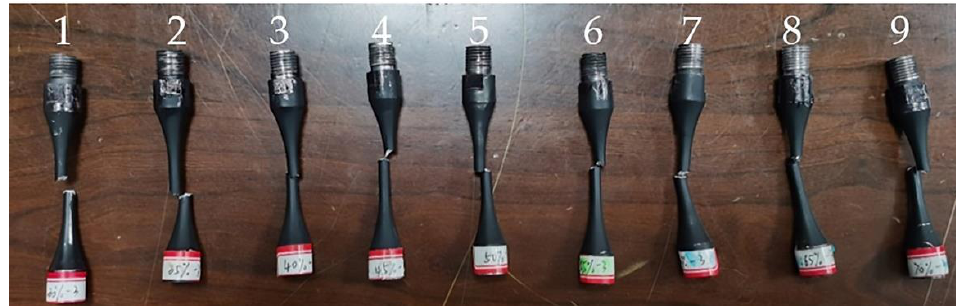
Figure 18. Sample fractured after test.